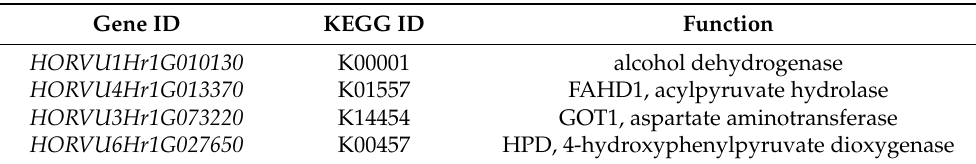
Table 2. Positive selective genes related to alkaloid compounds in the evolutionary stage from Wb-NE to